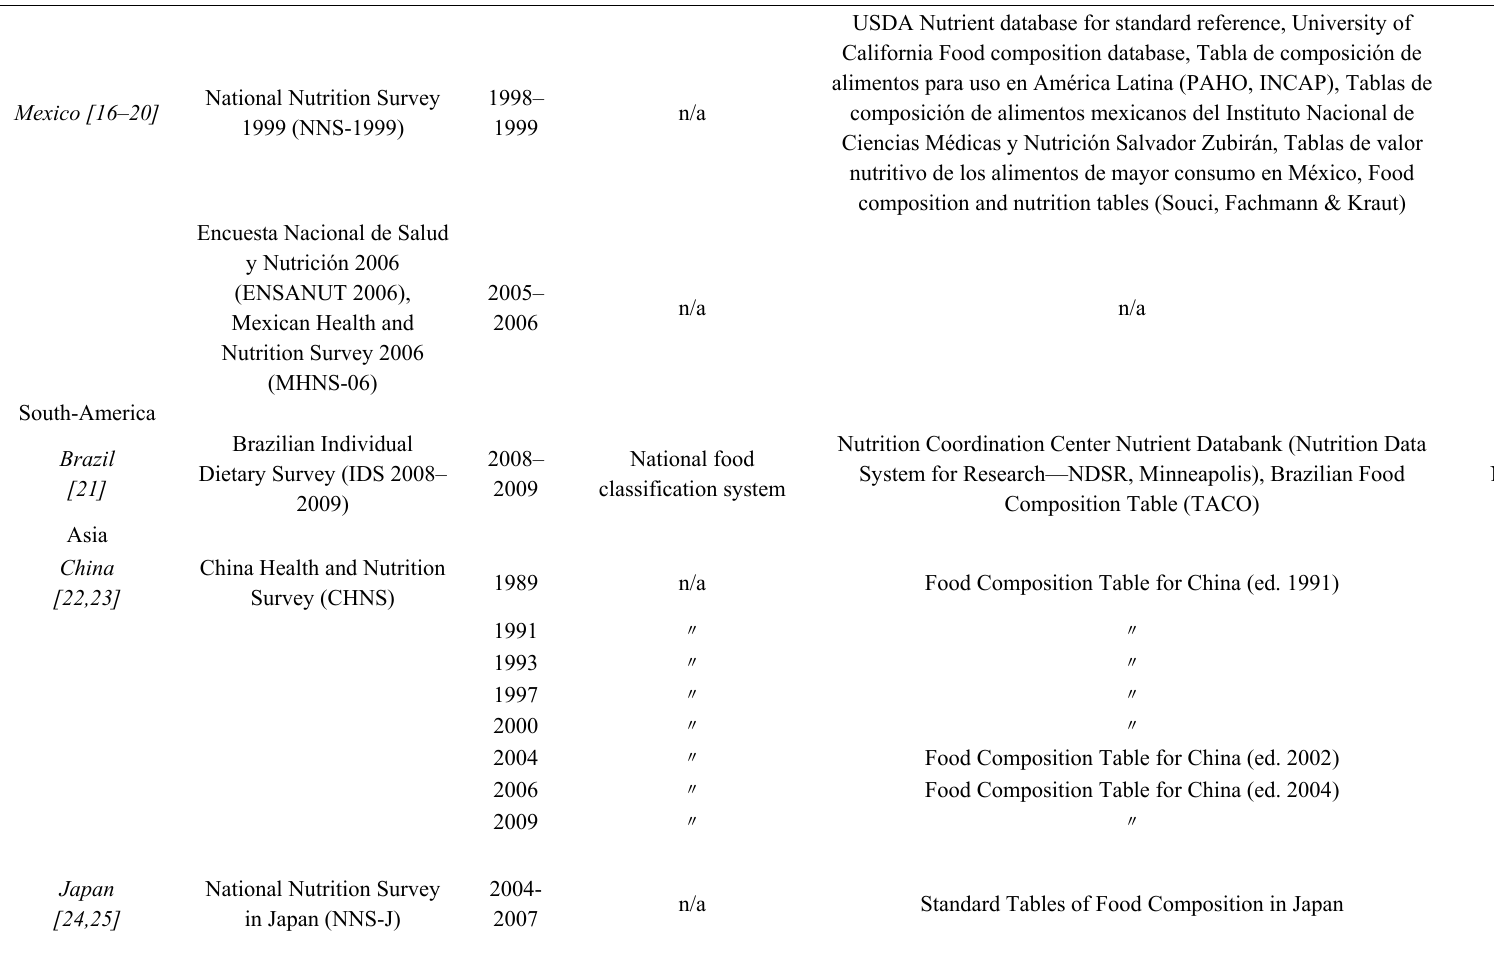
Food Composition Table for China (ed. 2002)